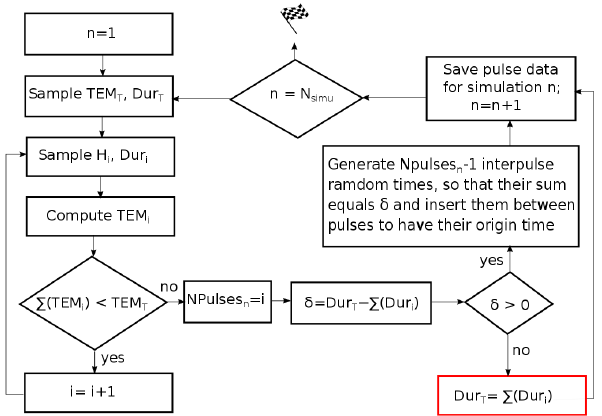
Figure 4. Proposed strategy to treat and describe the styles of pul- sating eruptions, characterized by a series of discrete short-lived events followed by occasional interruption of the tephra emission.